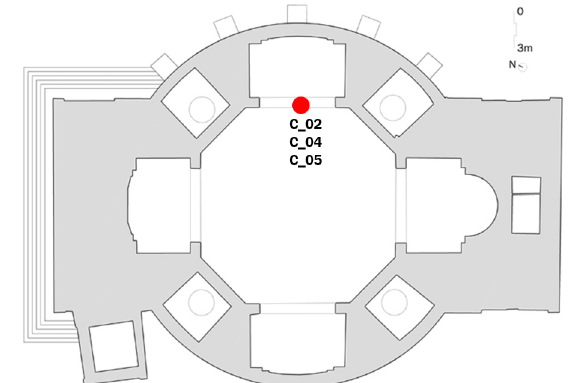
Figure 5. Map of the samples (Pilia